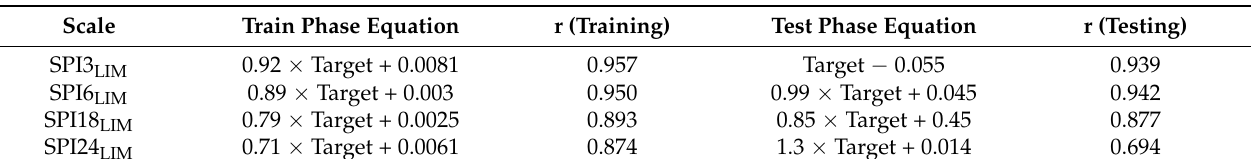
Table 5. Explainable equations of predicted SPIs via proposed ANN-FA vs their correlation between actual drought and predicted drought.